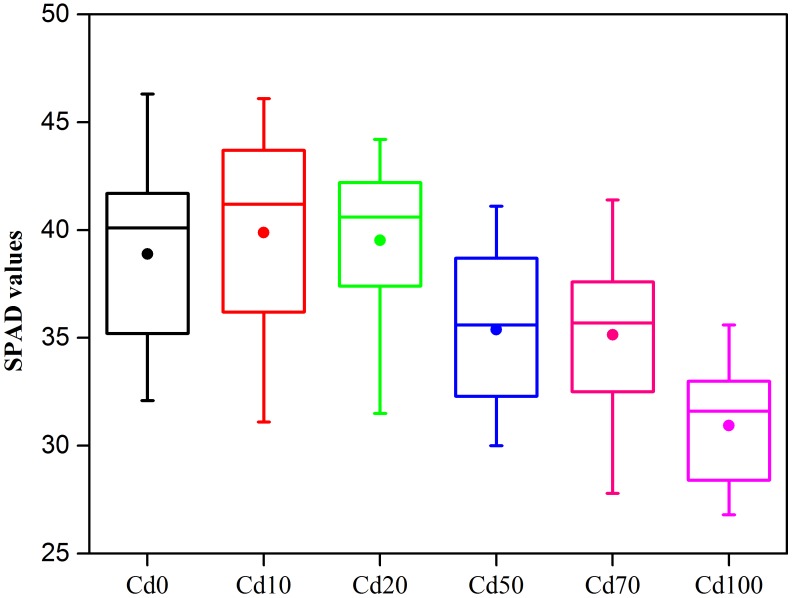
Boxplots of SPAD under different Cd stress. The solid circle in the box plots represents the mean values, n = 15.